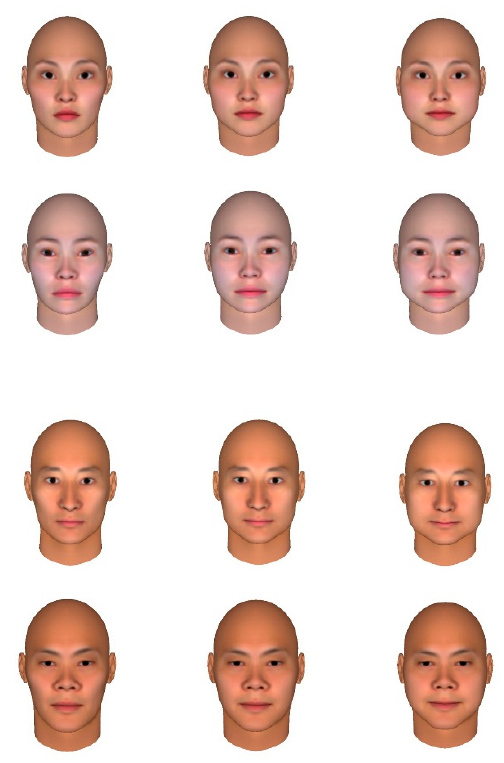
Figure 5. Examples of angular faces, neutral faces, and round faces are on the left, middle, and right, respectively.